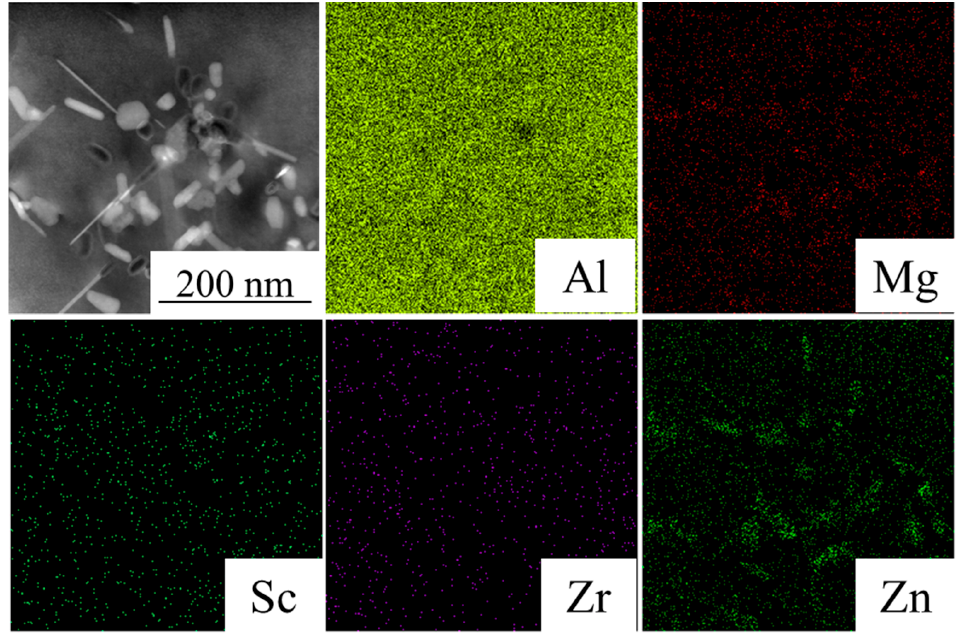
Figure 8. The TEM-EDS analysis of sample 4 in the as-printed status.